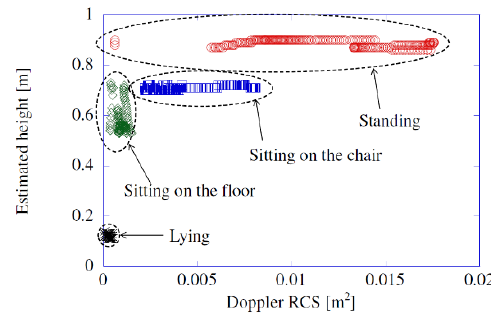
Figure 12. Training data based on height and Doppler radar cross section (RCS)